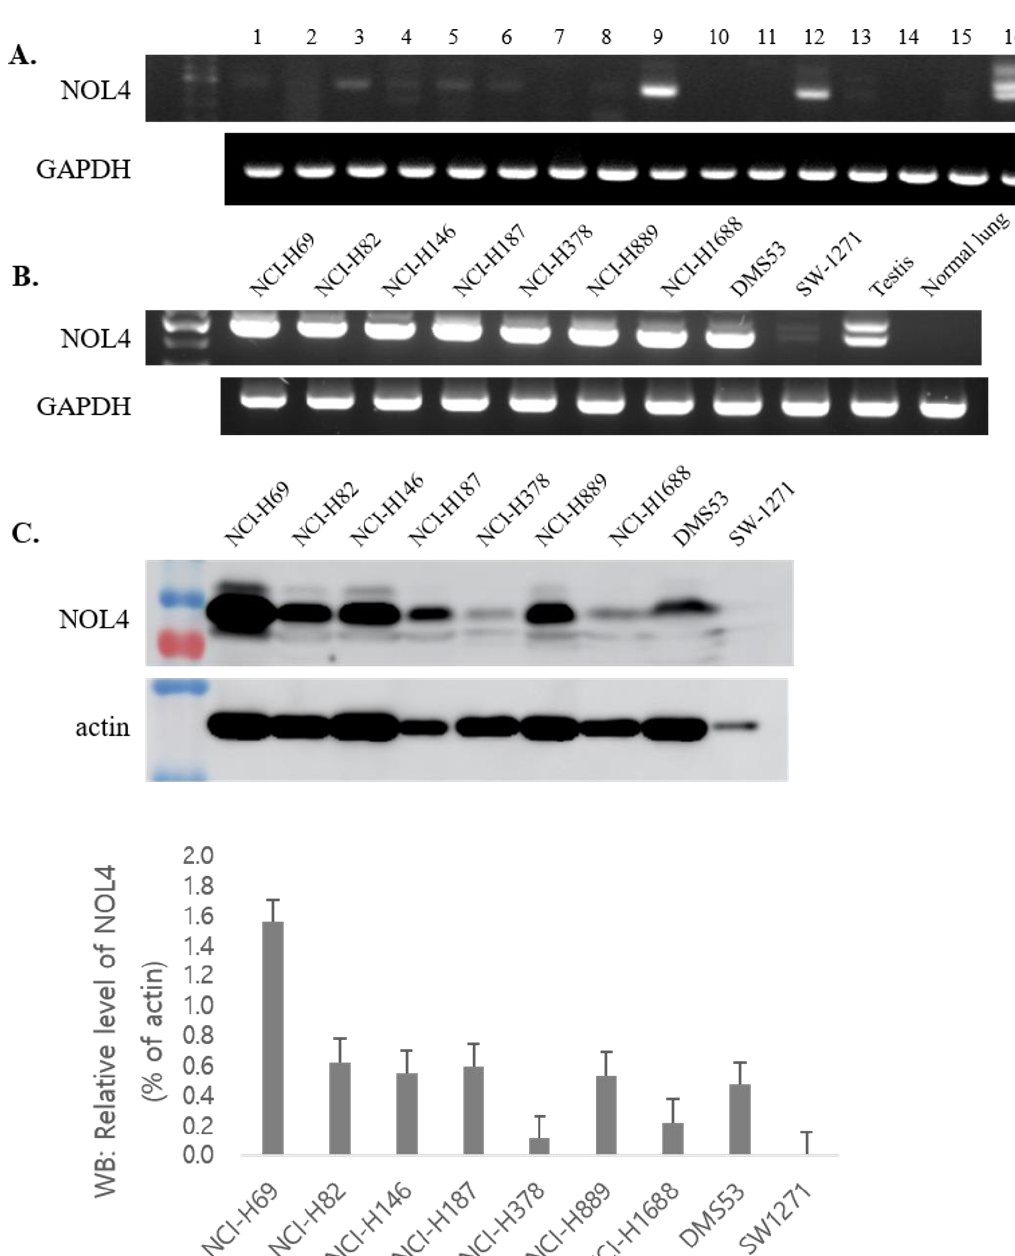
Figure 1. The mRNA and protein expression of NOL4 in normal tissues and small-cell lung cancer (SCLC) cell lines. RT-PCR was performed on mRNA expression of NOL4 in normal tissues ( A ) and SCLC lines ( B ). Western blot analysis was performed to evaluate the protein expression of NOL4 in SCLC cell lines, and the intensity ratio of each band was analyzed by Image J ( C ). Normal tissues were indicated as follows: 1, spleen; 2, thymus; 3, prostate; 4, ovary; 5, small intestine; 6, colon; 7, leukocyte; 8, heart; 9, brain; 10, placenta; 11, lung; 12, pancreas; 13, liver; 14, skeletal muscle; 15, kidney; and 16, testis. The cDNA templates were normalized using GAPDH, as shown in the bottom panel.